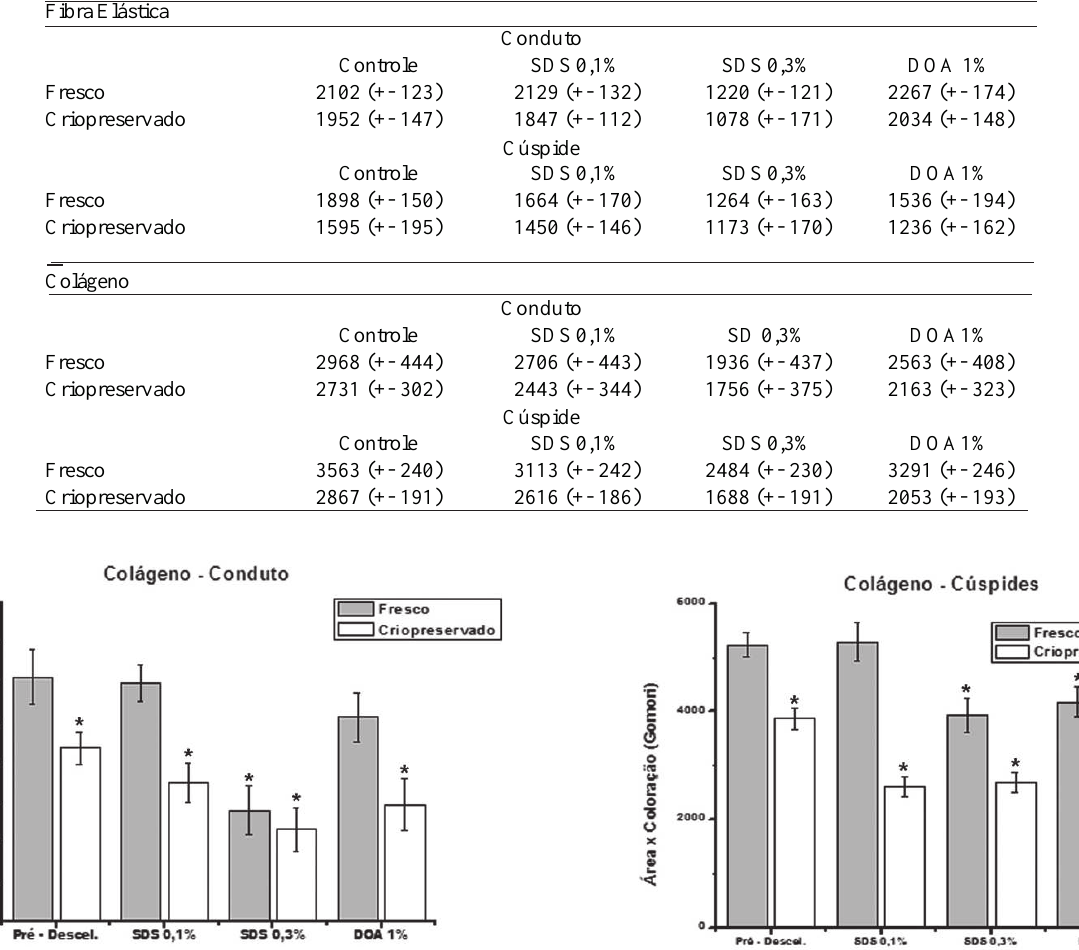
Fig. 4 - À esquerda: análise morfométrica de lâminas de conduto de ambos os grupos I e II, coradas com Gomori para observação quantitativa de colágeno. À direita: análise morfométrica de lâminas de cúspide de ambos os grupos I e II, coradas com Gomori para observação quantitativa de colágeno. * = P <